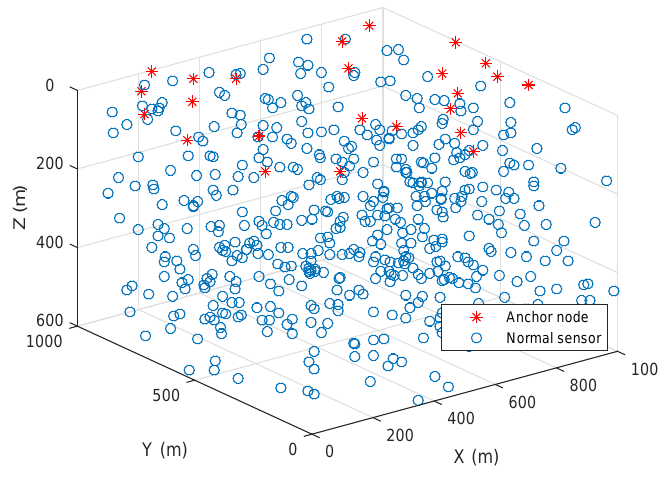
Figure 4. Deployment scenario